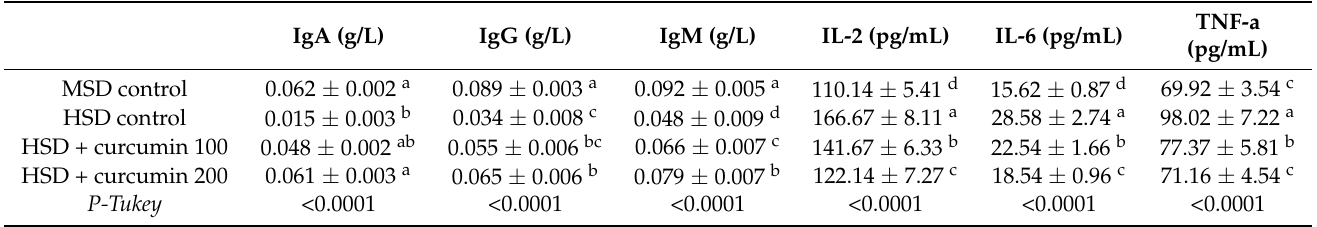
Table 6. Effect of curcumin on immune measurements in the serum of broilers reared under high stocking density.